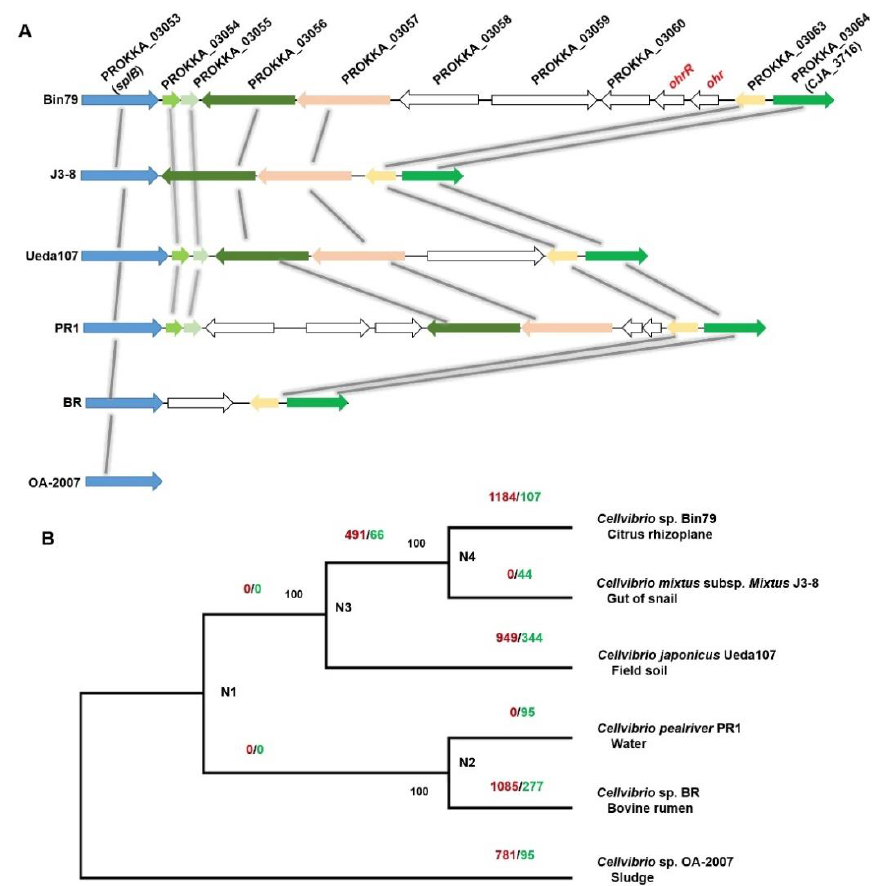
Figure 5. ( A ) Comparison of the ohr and ohrR gene clusters of Bin79 with related Cellvibrio genomes. Conserved and homologous genes ( > 50% identity) are colored and linked. ( B ) Results of gene gain / loss analysis. Numbers on the branches indicate the number of gene gain (left, red colored) and loss (right, green colored) events at the divergence event. The maximum likelihood phylogenetic tree was reconstructed based on the concatenated sequences of 2018 core genes. Bootstrap support values from 1000 replicates are indicated at the nodes. The isolation sources of the strains are indicated under the strain name.